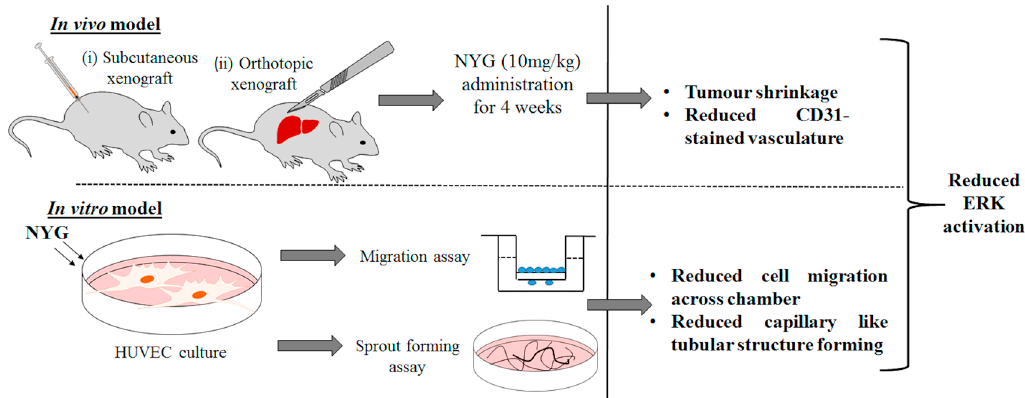
Figure 6. Schematic diagram of in vivo and in vitro experimental procedures demonstrate the anti-tumor effect of NYG through mediating HUVECs migration and sprout formation.